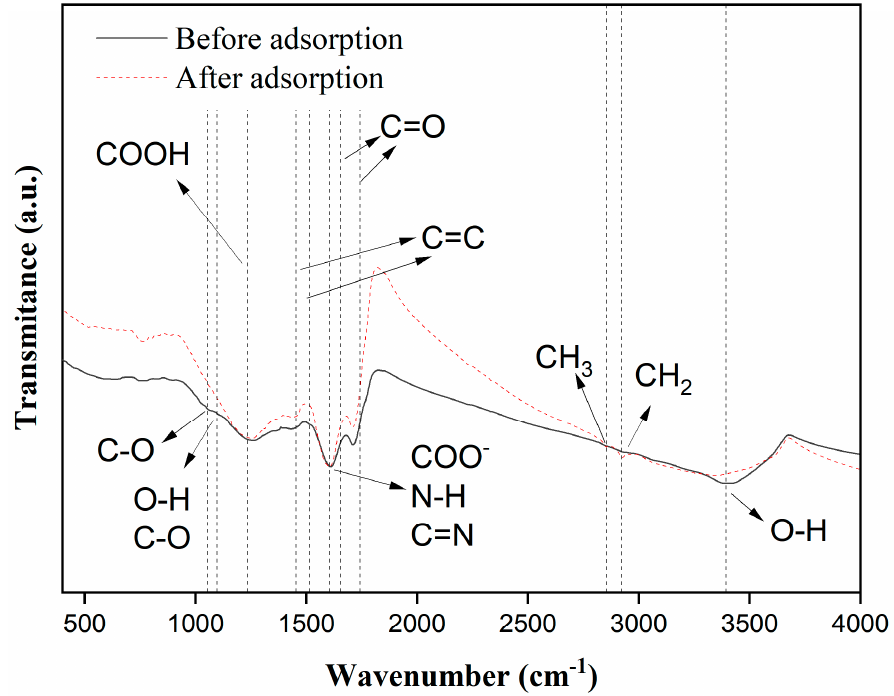
Figure 3. FTIR spectra of the adsorbent before and after the column adsorption of ATZ using Moringa oleifera Lam. seeds as adsorbents.